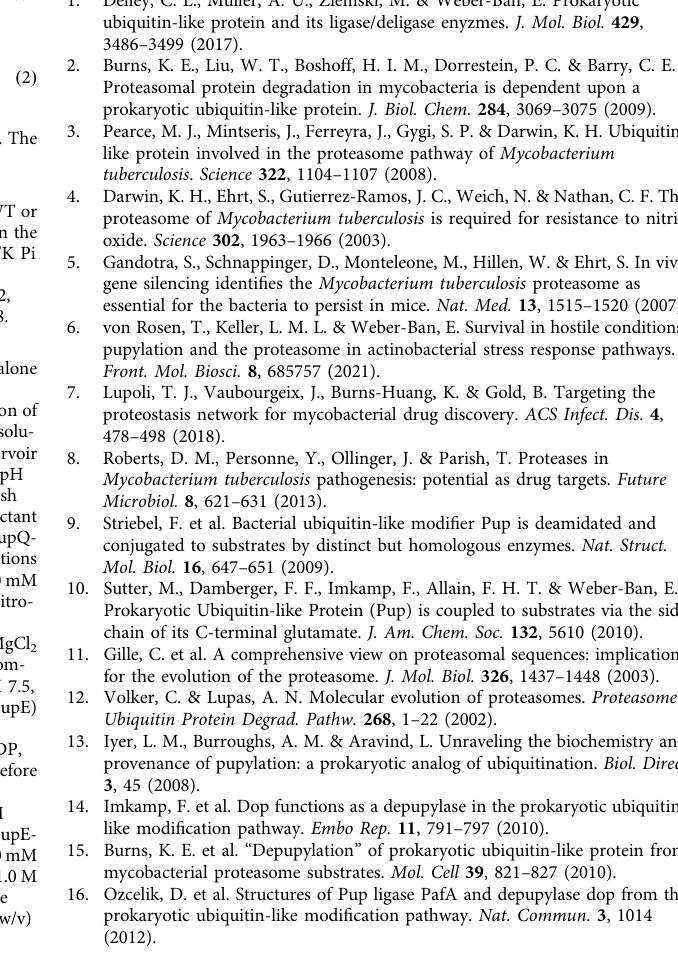
are summarized in Table 1. All structure images were generated with PyMol (The PyMol Molecular Graphics System, version 2.0, Schrodinger, LLC). Structural comparison . Comparisons of structures in this study were performed by using the super or align command in PyMol depending on the